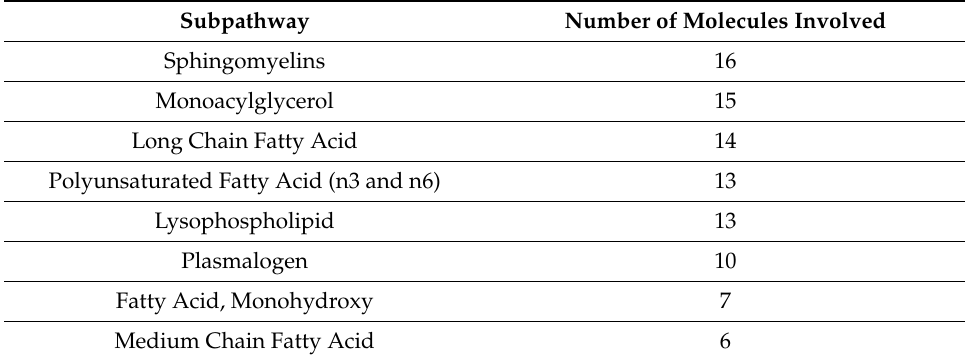
Figure 3. ( A ) Lactate, ( B ) succinate, and ( C ) N-acetylcysteine levels in the supernatant significantly increased with LR growth in HBM versus formula. Lactate and succinate are involved in the glyoxylate cycle; N-acetyl cysteine is involved in methionine and cysteine metabolism and antioxidant formation. Table 2. Decreased lipids in HBM with LR in comparison to HBM without